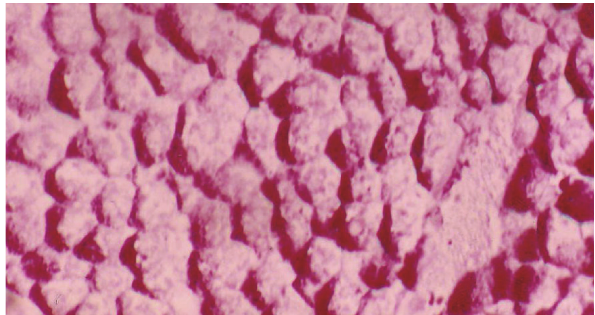
Figure 10: Photomicrograph of liver section of diabetic rat offspring after one week. Notice the difference in distribution and intensity of stain ( × 400).